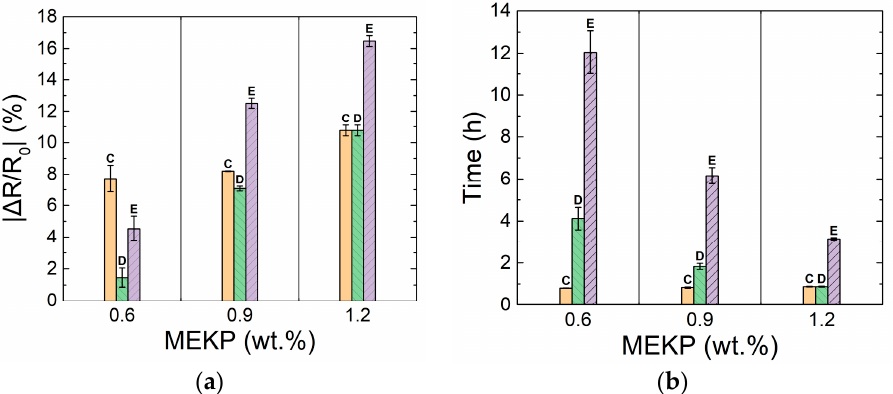
Figure 6. Average values of Δ R/R 0 and their corresponding elapsed times for selected points (C, D, and E). ( a ) Absolute value of Δ R/R 0 , ( b ) corresponding elapsed times.